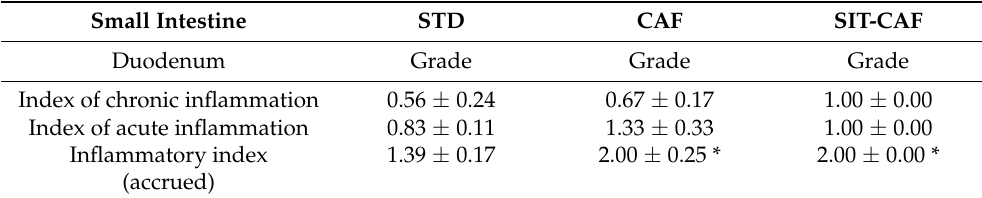
Table 6. Inflammatory parameters affected by cafeteria diet and GSPE treatments on intestinal index of inflammation in Wistar rats. SIT, simultaneously intermittent GSPE treatment (500 mg/kg body weight). Values represent mean ± SEM; n = 3–8.